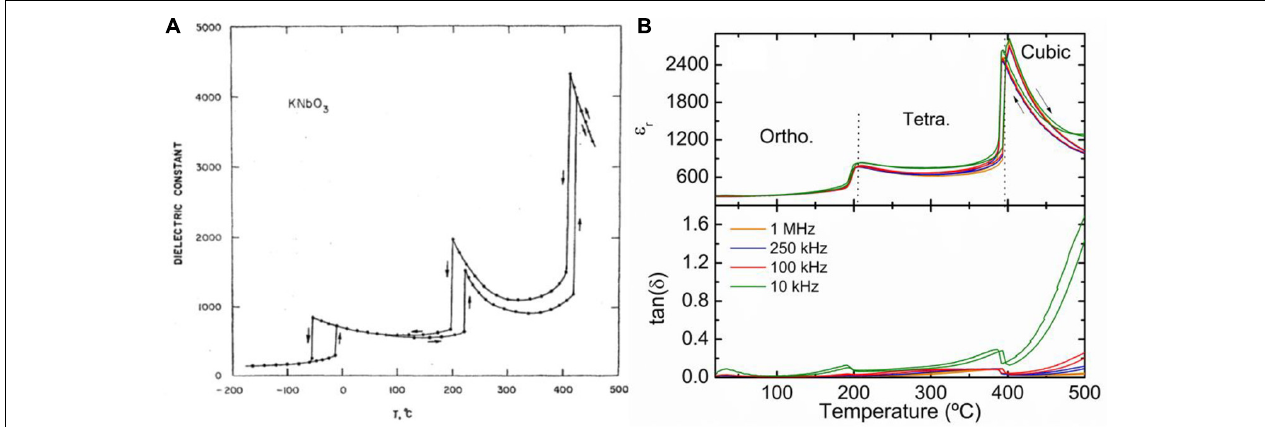
FIGURE 3 | Temperature dependence of the dielectric permittivity of KN (A) single-crystal [Reproduced from https://doi.org/10.1103/PhysRev.96.581 (Shirane et al., 1954a)] and (B) ceramics [Published by The Royal Society of Chemistry, https://doi.org/10.1039/C6TC05515J, https://creativecommons.org/licenses/by/3.0/ (Pascual-Gonzalez et al.,